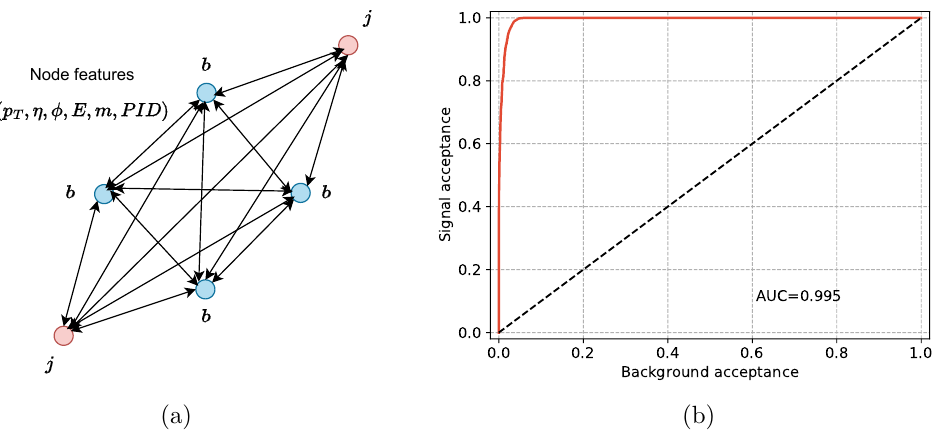
Figure 6 . A representative diagram of an event as a fully connected graph is shown on the left. The network performance is shown on the right with a receiver operating characteristic (ROC) curve along with the corresponding AUC = 0 . 995